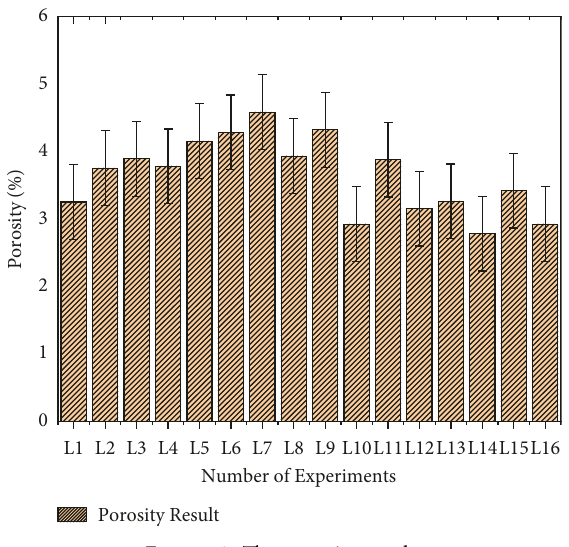
Figure 3: The porosity result.